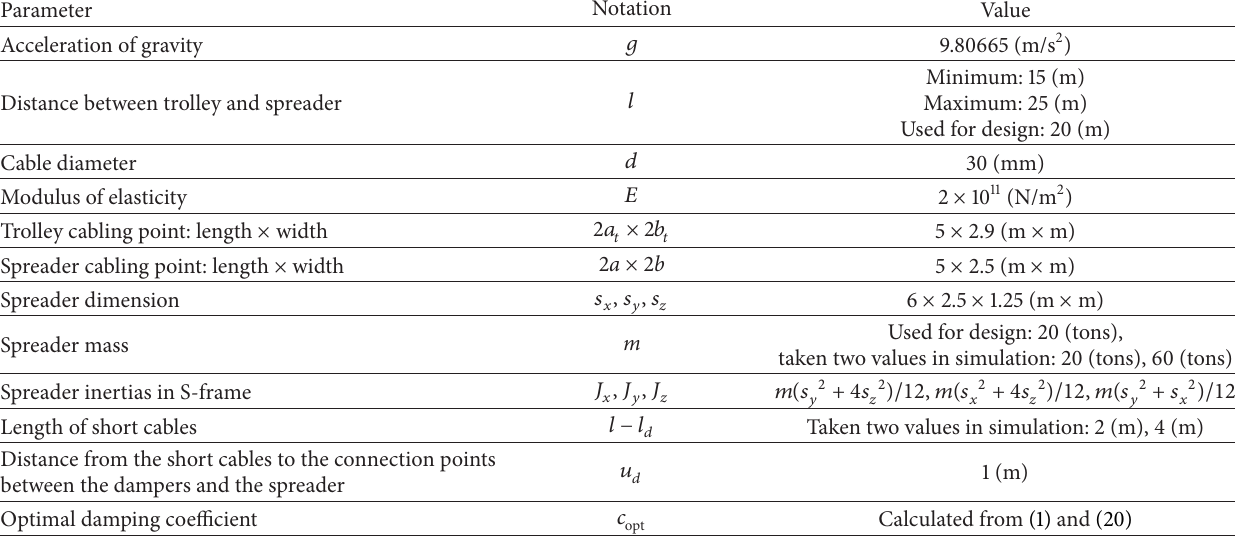
Table 1: Numerical values used in simulation.